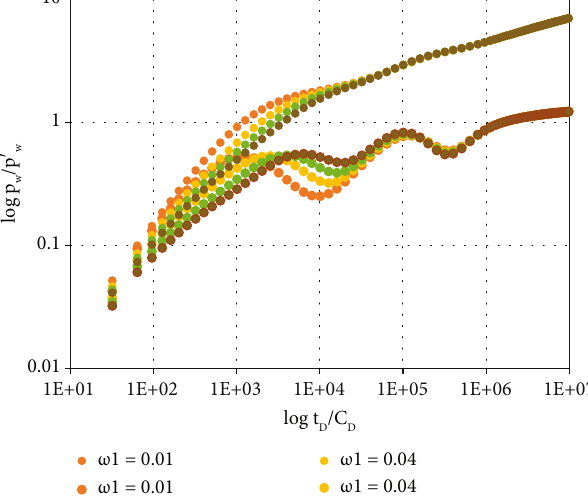
Figure 6: The in fl uence of mobility ratio of the inner zone to the outer zone on pressure di ff erence and pressure di ff erence derivative curve.